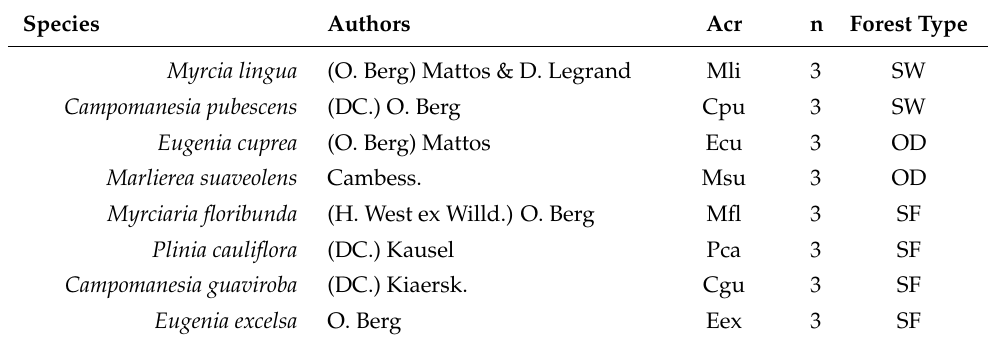
Table 1. List of Myrtaceae tree species chosen to study the acquisition, absorption, transport, and use of N. Acr—the species acronym, SW—Savanna Woodland, OD—Ombrophylous Dense and SF—Semideciduous are types of tropical forest. The references that support the listed species consid- ered the information from the Virtual Herbarium of the Reflora Project (Flora do Brasil 2020). To see more, visit: https://reflora.jbrj.gov.br/reflora/PrincipalUC/PrincipalUC.do?lingua=en (accessed